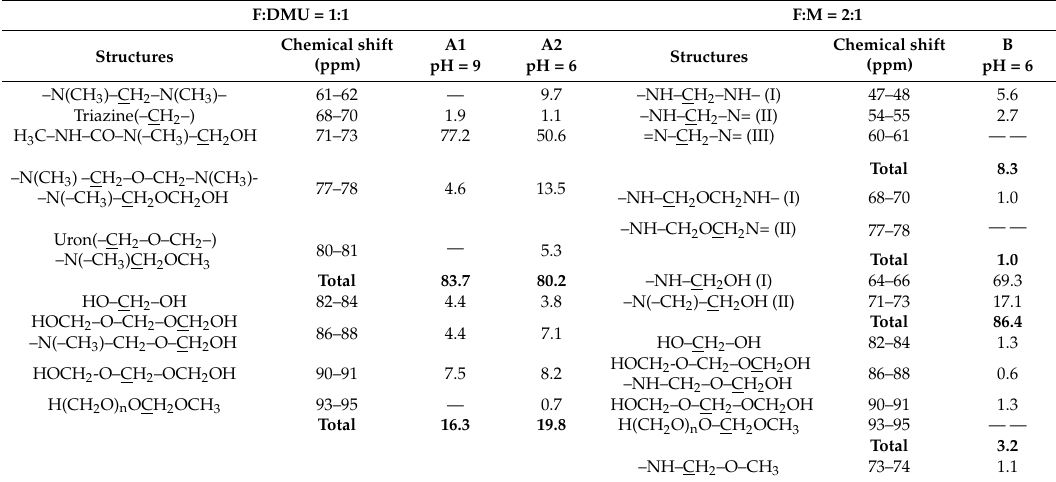
Table 1. 13 C-NMR assignment and quantitative results (%) for DMUF and MF